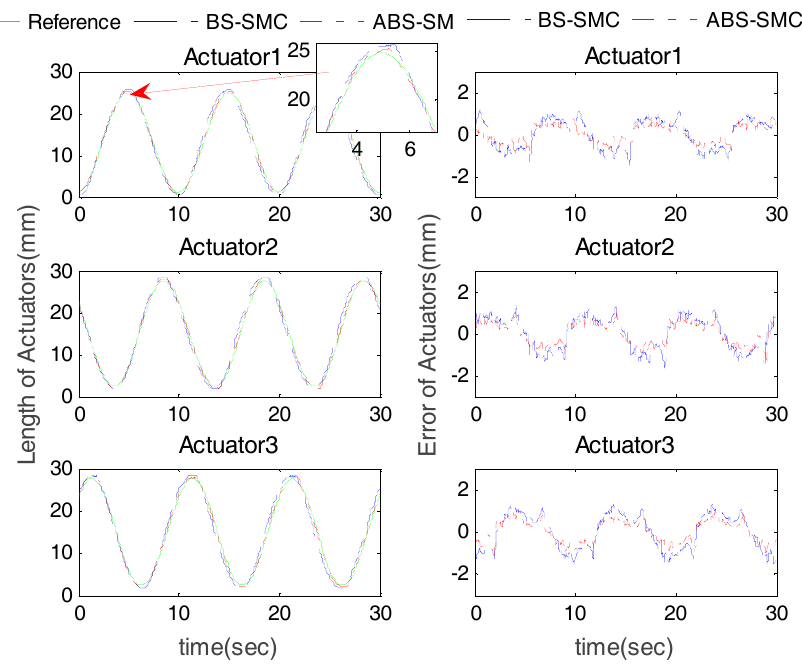
Figure 6. Actuator position tracking results (without subject). Sensors 2018 , 18 , 66